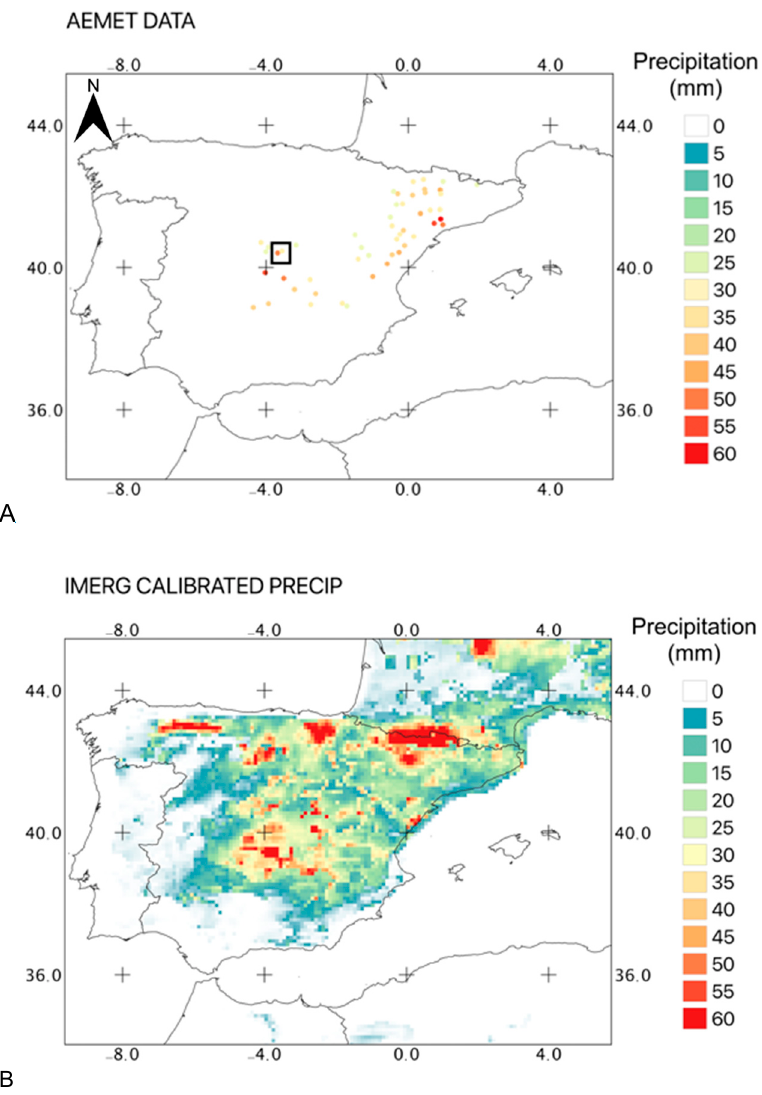
Figure 9. ( A ) Official AEMET data of the precipitation amount in Spain from January 7th 07:00 Z to January 12th 07:00 Z (Table in [37]; Madrid area is indicated by a square), and ( B ) IMERG PrecipCal estimates for the same period, assuming snow where the probability of liquid precipitation is lower than 70% (to ease comparisons, the two plots can be found superimposed in animated format as supplementary information).